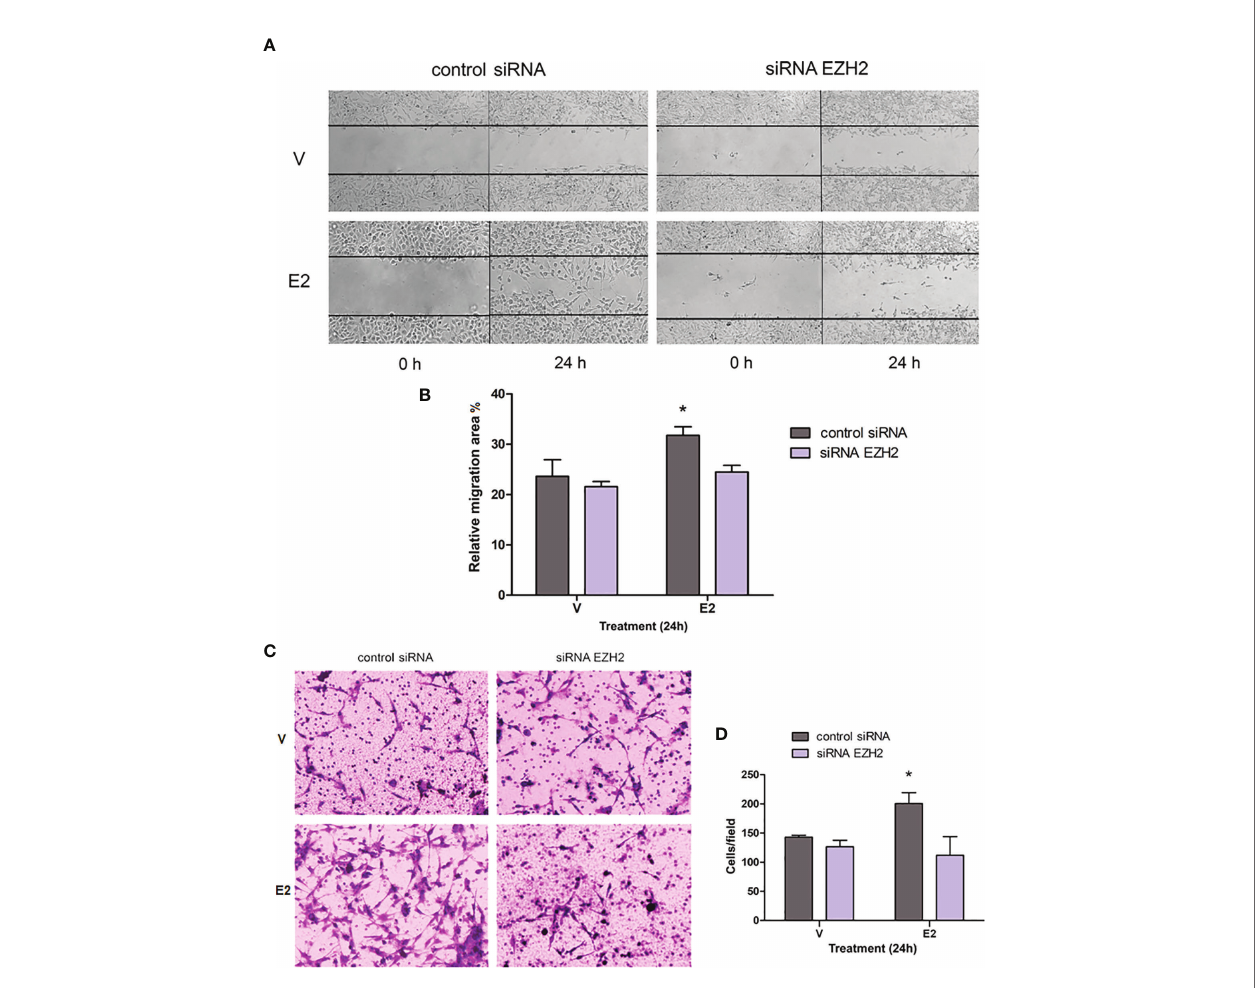
FIGURE 4 | Effect of EZH2 silencing on E2-induced migration and invasion. (A) Wound healing assays were performed in the U251 cell line transfected with control siRNA or EZH2 siRNA and treated with E2 (10 nM) or V (0.02% CDX). Representative images of the scratch area at 0 and 24 h. (B) Relative migration area (%) of U251 cells into wound area was measured 24 h after scratch formation. Graph data are shown as mean ± S.E.M., n = 3. *p < 0.05. vs. the other groups. (C) Transwell assays were carried out in U251 cells treated as previously described. Representative photographs of the invading cells at the bottom of the transwells (cells that penetrated matrigel) stained with 0.1% cresyl violet after 24h of treatment (D) and the corresponding quanti fi cation. Results are expressed as the mean ± S.E.M., n = 3. *p < 0.05. vs. the other